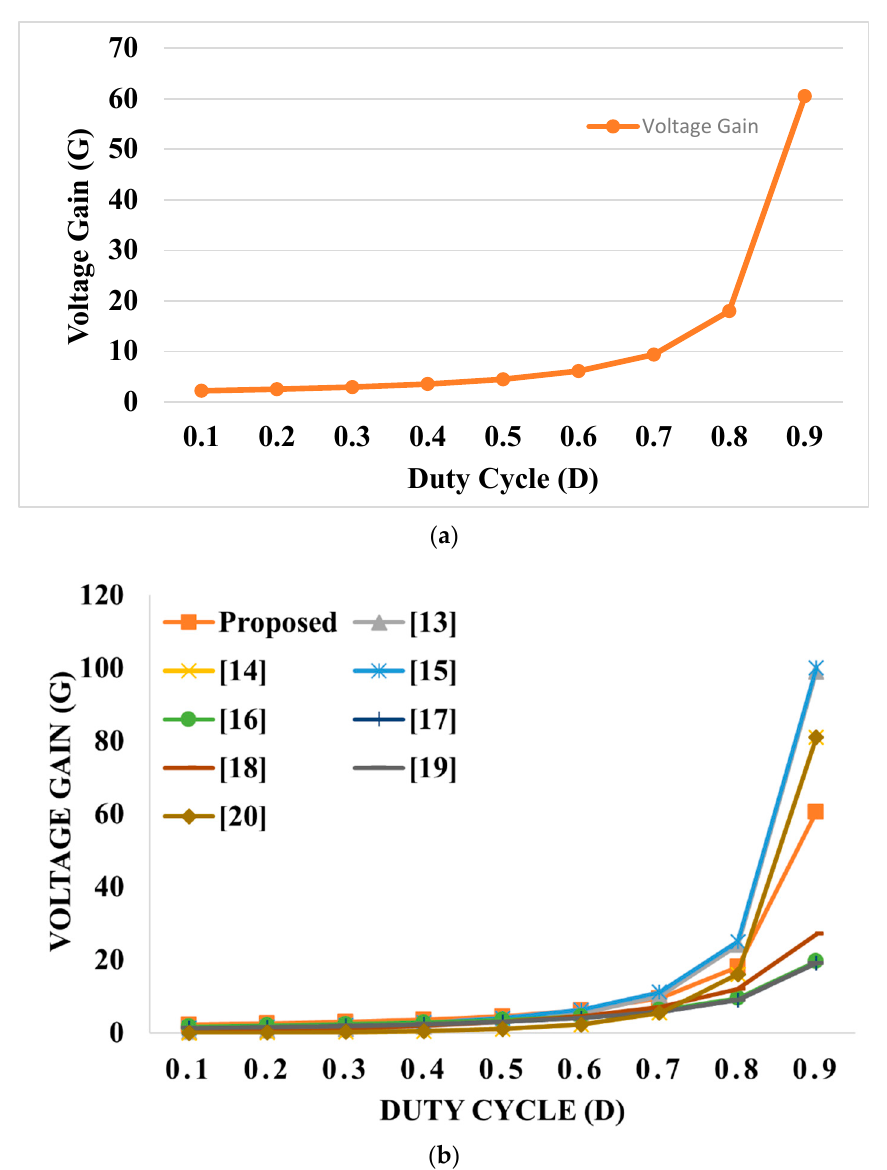
Figure 7. Voltage gain vs. duty cycle: ( a ) proposed HG-SIQBC Topology; ( b ) HG-SIQBC vs. other topologies—comparison of voltage gain with duty cycle ([13–20]) .